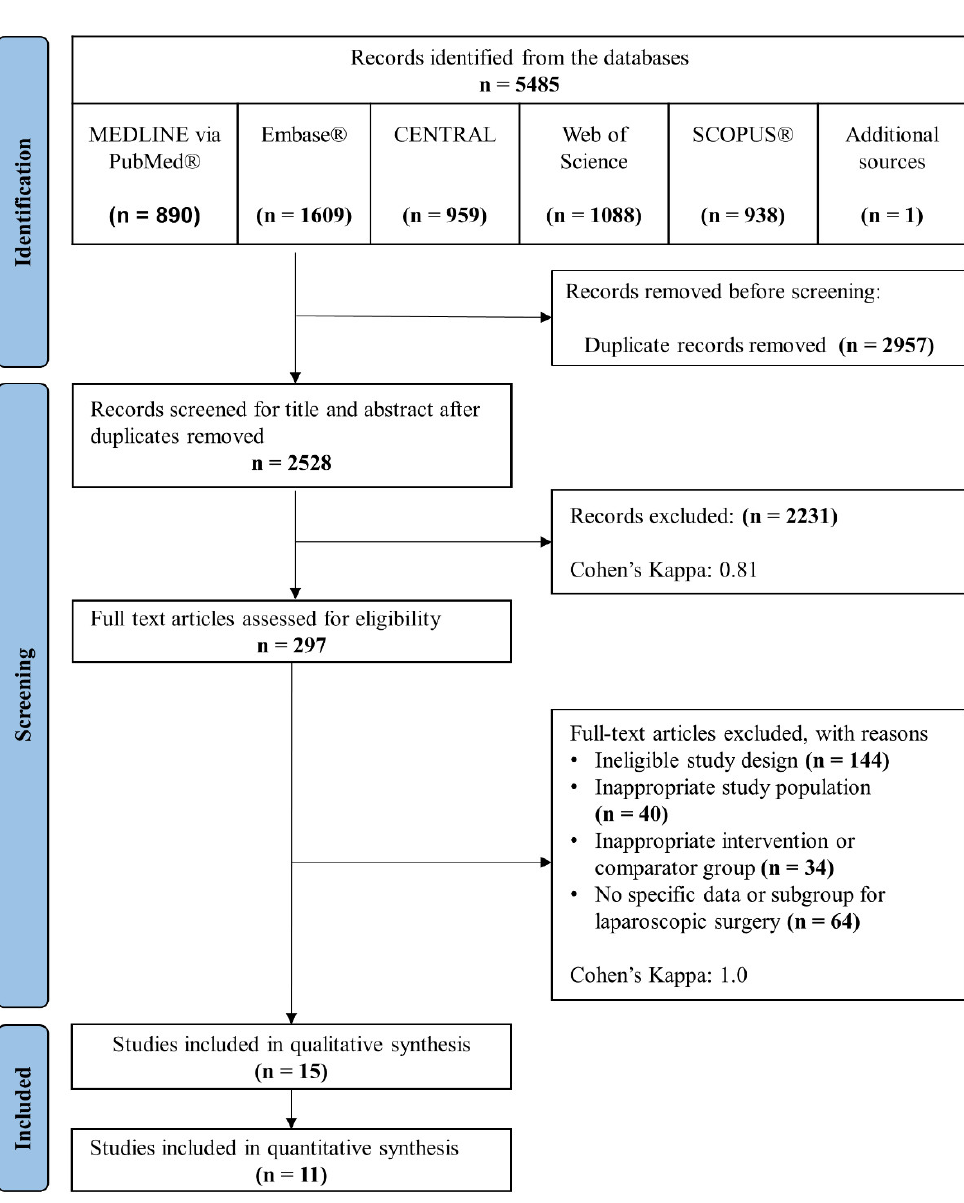
Figure 1. PRISMA flowchart of selection.